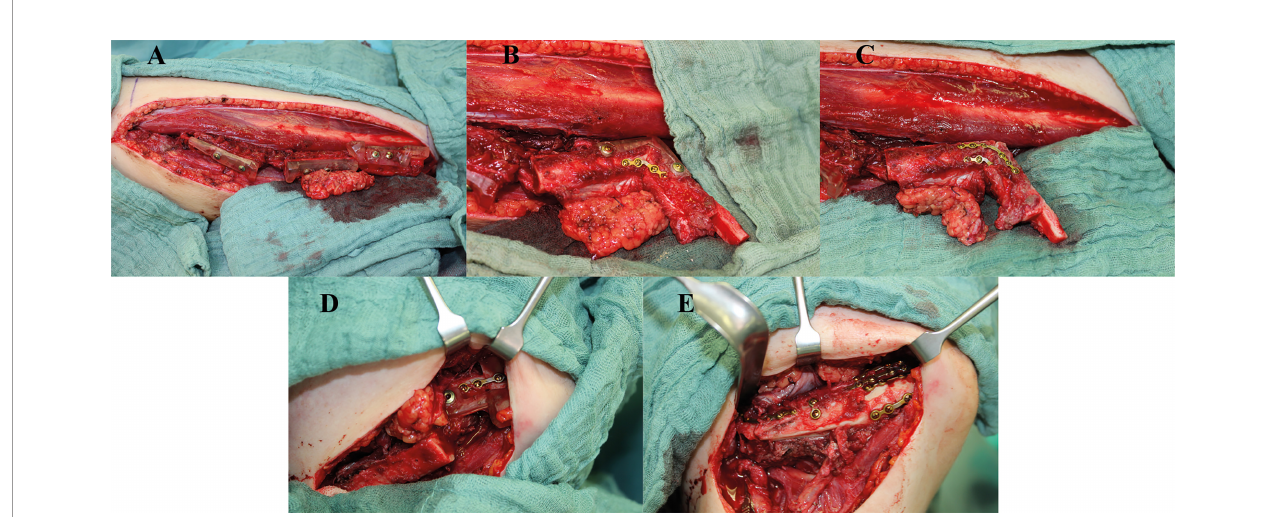
FIGURE 5 | Clinical example with intraoperative images of a case with hemimandibulectomy with exarticulation (Brown IIc) due to chronic osteomyelitis. Reconstruction was performed with a three-segment free fi bular fl ap (FFF), with the corpus section reconstructed with a double-barrel component for better neomandibula contouring and crestal bone position for secondary enossal implant insertion. (A) FFF following osteotomies with temporarily applied cutting guides, (B, C) reconstruction of the ramus including neo-condylar head and crestal corpus section applying a repositioning aid and pre-bent 2.0 miniplate osteosynthesis, (D) positioning of the neomandibula with another repositioning aid, and (E) fi nal reconstructive result with the double-barreled caudal FFF section for optimized bony